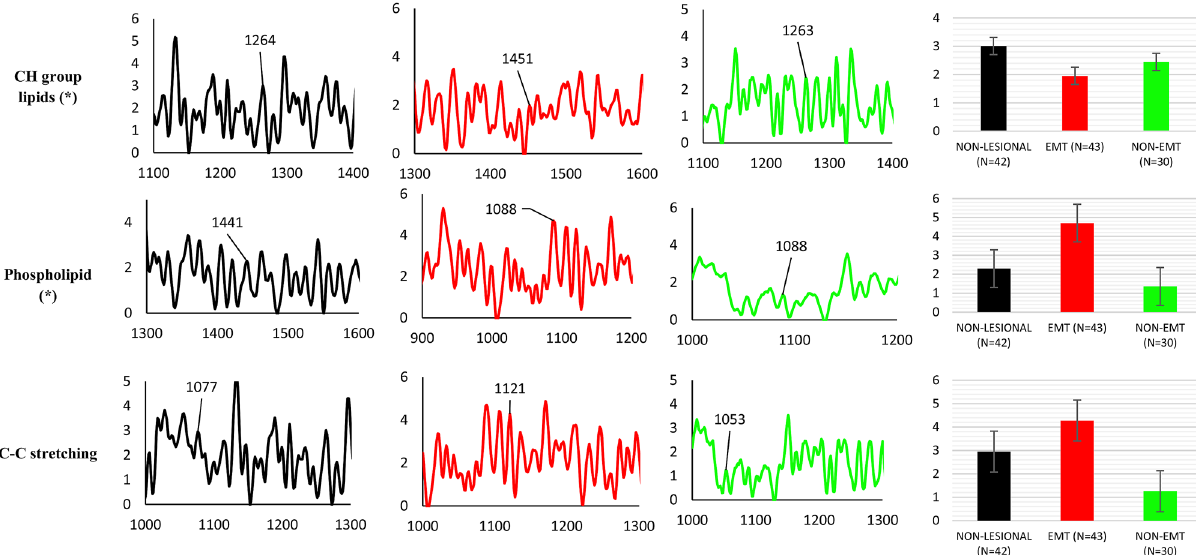
Figure 4. Summary of lipid vibrational bands observed for dewaxed samples (Group 1) in non-lesional, EMT and non-EMT breast cancer tissue. The x- and y-axes represent the wavenumber and normalised (vector normalisation) intensity respectively. The black colour trace represents the non-lesional tissues, red colour represents EMT tissues and green colour represents non-EMT tissues. Comparison of the relative intensity of lipid Raman bands in dewaxed samples between non-lesional, EMT and non-EMT breast tissue samples are depicted in the bar charts. Each column represents the average of spectra for each type of tissue. The value of N represents the number of Raman spectra acquired for each sample, shown within the brackets. The error bar represents standard deviation. Note: the x-axis represents the tissue type and y-axis is Raman intensity. (*) denotes a statistically significant difference between the groups reported by the ANOVA